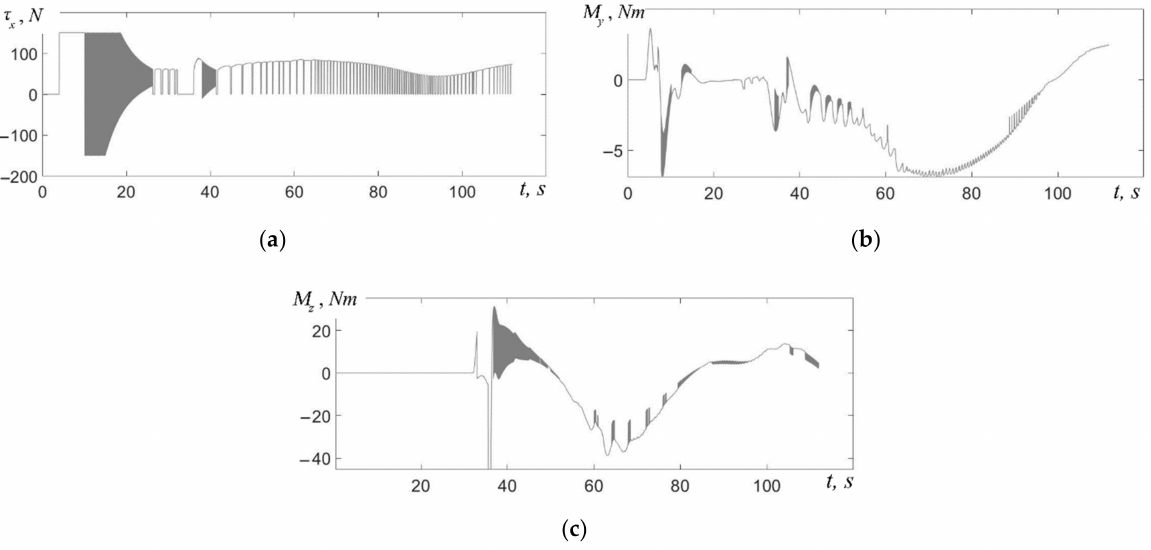
Figure 7. The changes of control signals of AUV-follower: ( a ) is the τ x ; ( b ) is the M y ; ( c ) is the M z